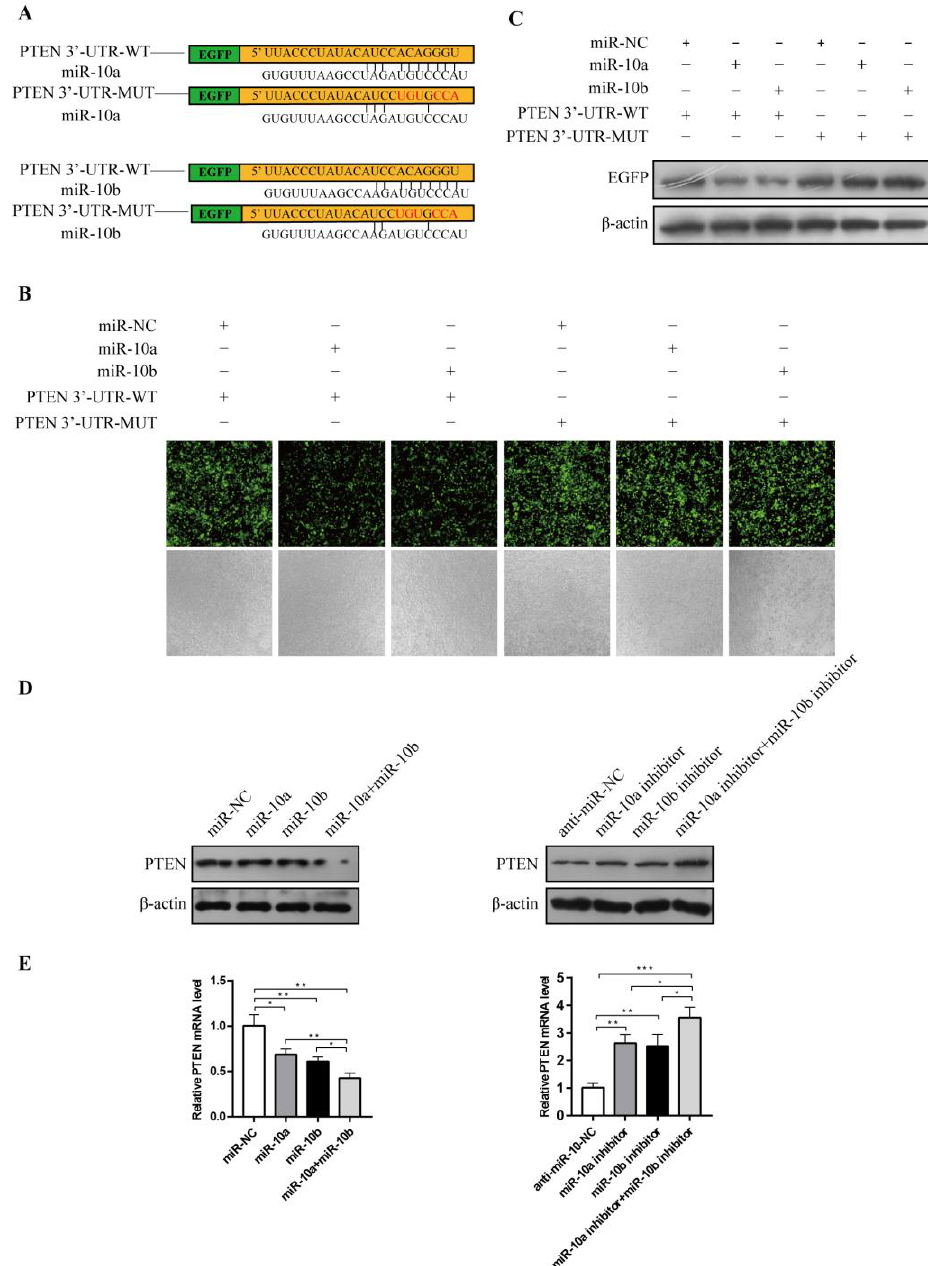
Figure 4. Both miR-10a and miR-10b targeted the PTEN to upregulate PTEN expression. ( A ) Tar- getScan predicted PTEN- 3′ -UTR for miR-10a and miR-10b binding. ( B ) Transfection of miRNA-NC, miRNA-10a, or miRNA-10b in an EGFP fluorescent reporter assay using different PTEN- 3′ -UTR mutational states. ( C ) Western blot for EGFP expression following transfection. ( D ) Western blot for PTEN expression following miR-NC, miRNA-10a, miR-10b, or both miR-10a and miR-10b transfec- tion. ( E ) RT-qPCR analysis for PTEN mRNA following miR-10a, miR-10b, or both miR-10a and miR- 10b inhibitor transfection. * p < 0.05, ** p < 0.01, *** p < 0.001.